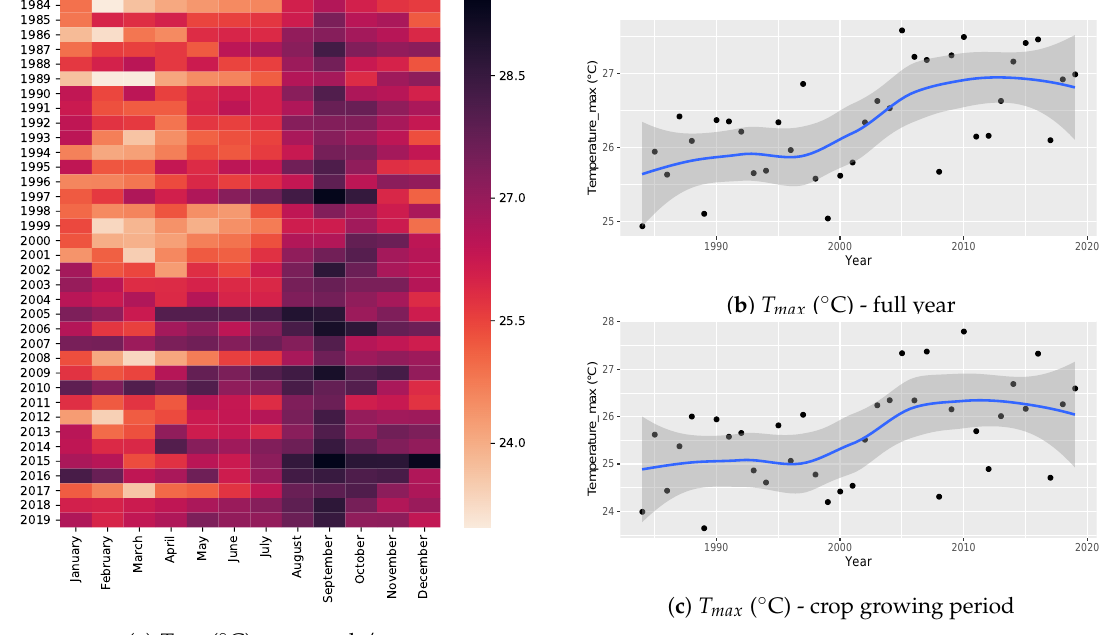
Figure A9. Time series of average maximum temperature ( ◦ C) in Loja from 1984 to 2019. ( a ) Heat-map of T max ( ◦ C) per each month and year. The color scale represents the temperature in ◦ C. ( b ) T max ( ◦ C) averaged during the full year. ( c ) T max ( ◦ C) averaged during the maize crop growing period in Ecuador (January–May). Each dot represents one record, the blue line shows the smoothed time series and the shaded area represents the 95% confidence